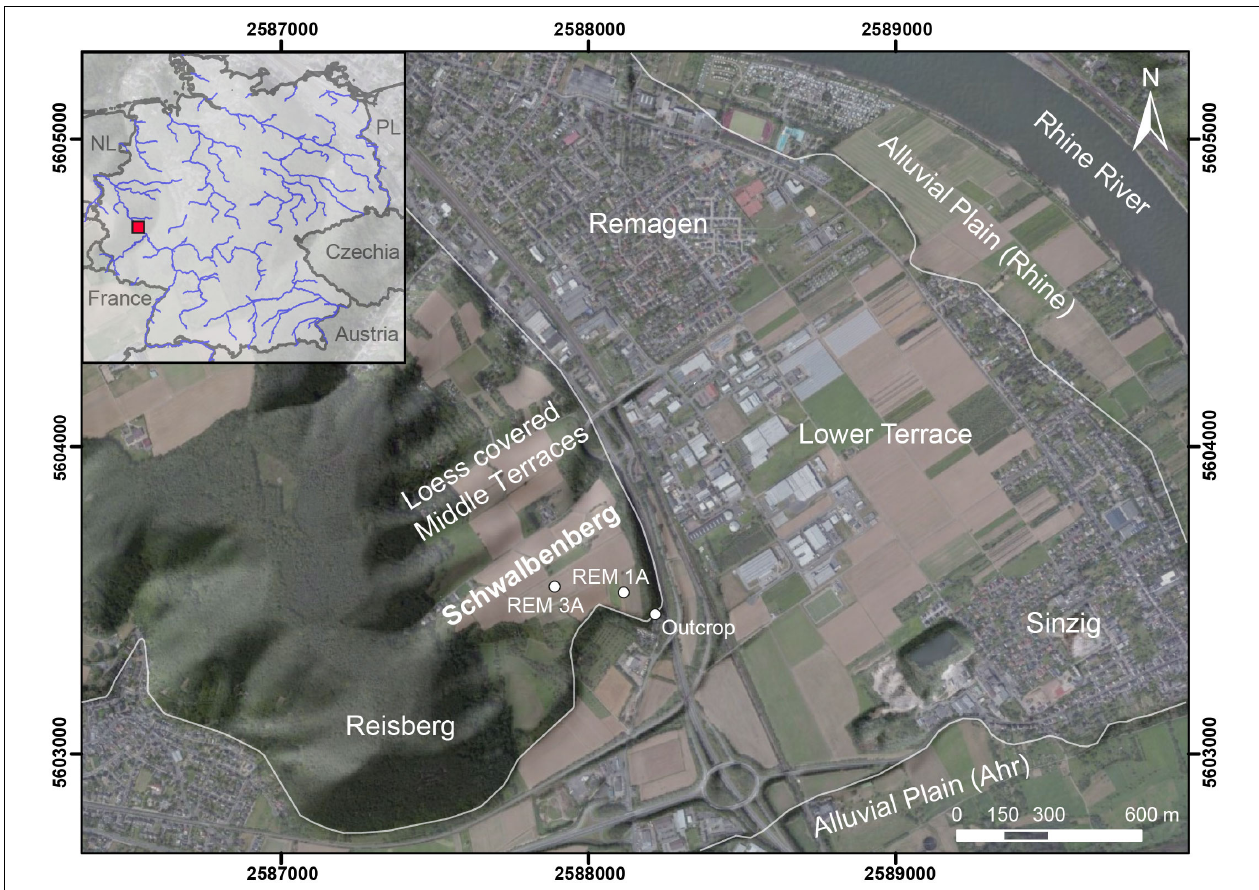
FIGURE 1 | Overview of the Schwalbenberg site in the Lower Middle Rhine Valley, Germany. The plateau-like loess relief developed on top of the Lower Middle Terrace dedicated to the penultimate glaciation (e.g., Boenigk and Frechen, 2006). Schirmer and co-workers (e.g., Schirmer, 2012; Schirmer et al., 2012) formerly investigated a 13 m thick LPS outcrop (white dot). Later on, geochemical investigations (XRF) were performed on samples derived from this outcrop by Profe et al. (2016). Sediment core (REM 1A) was obtained in mid-slope position by Klasen et al. (2015) trying to develop a luminescence chronology. The 26 m thick sediment core under investigation (REM 3A) is located in interfluve position of the